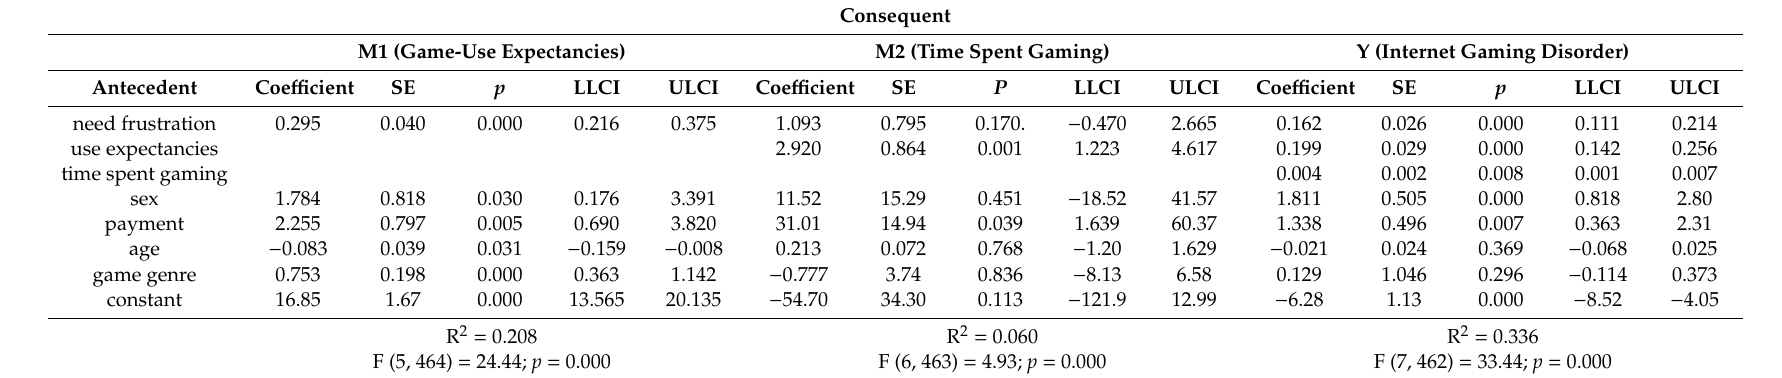
Table 2. Regression coe ffi cients for study variables and covariates over mediators and